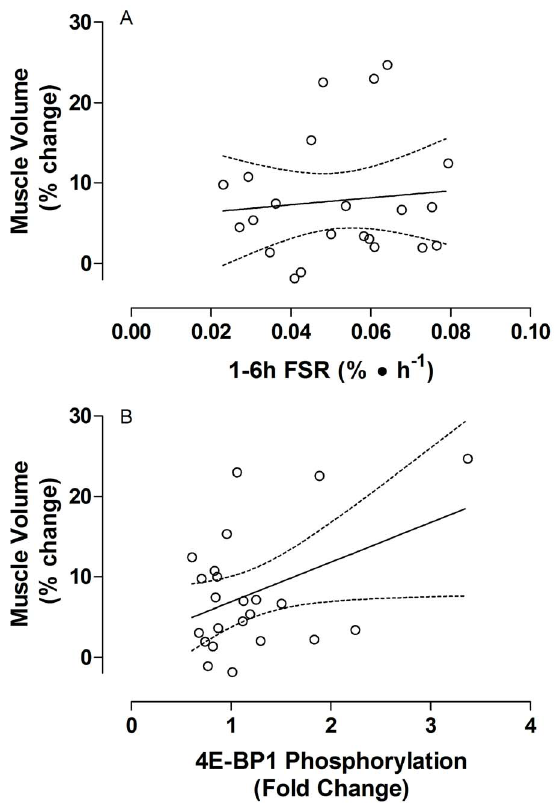
Figure 4. Myofibrillar Protein synthesis. FSR is calculated at rest and after an acute bout of resistance exercise and protein ingestion prior to the start of the resistance training period. The other rates were calculated from 1 to 3 hours and 3–6 hours after the resistance exercises. Each circle, square, and triangle represents a single subject at rest, 1–3 and 3–6 hours post exercises respectively * Significantly different than rest P , 0.05.